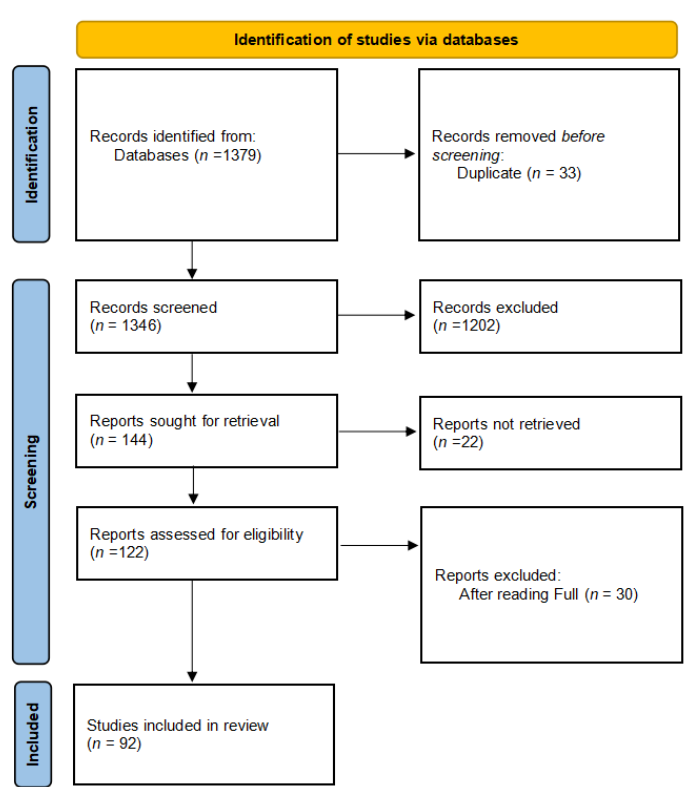
Figure 1. Flowchart review process and identifying the number of relevant